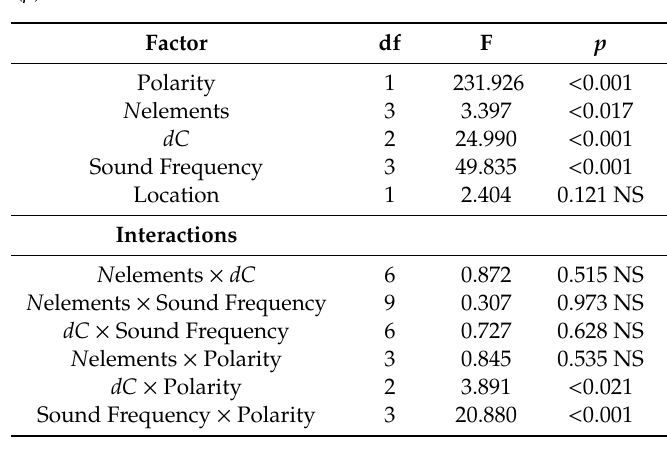
Table 2. Results from the 4-way ANOVA on the response time data ( n = 1920) with F statistics relative to e ff ects of factors and their interactions, degrees of freedom (df) of the given comparison, and statistical probability limits ( p